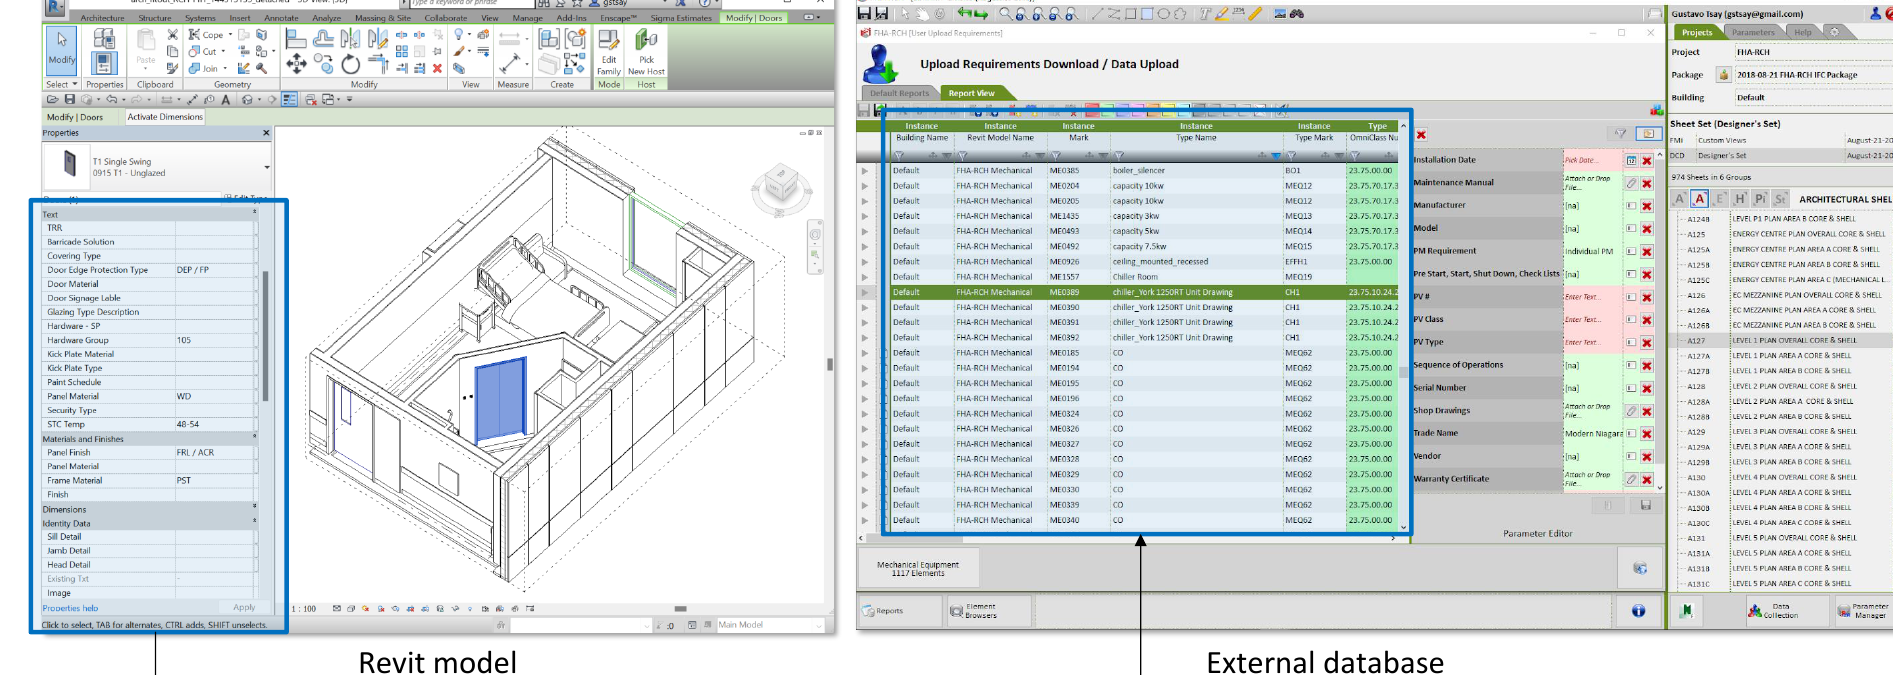
Figure 12. Schematic example of the information developed in the design models being incorporated into the external database